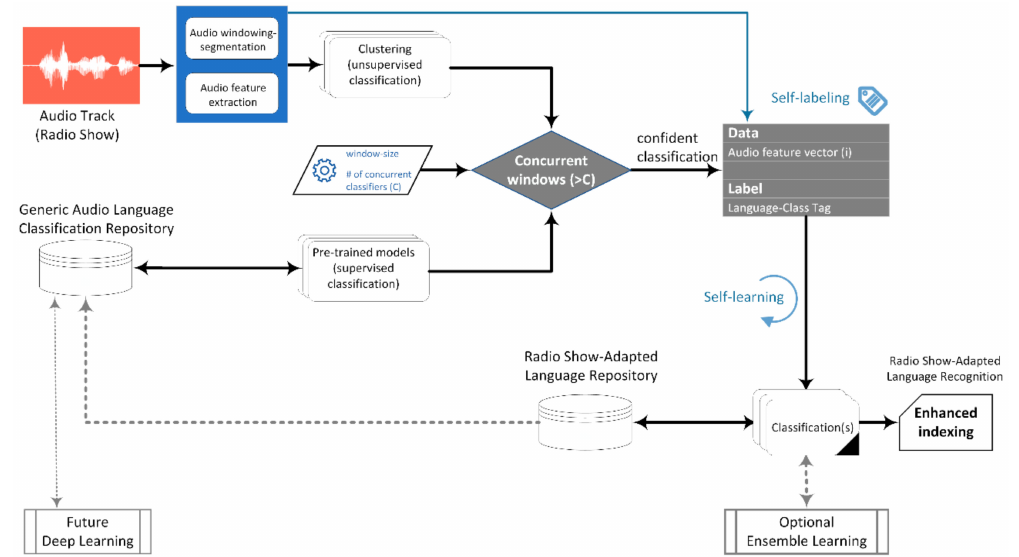
Figure 1. Block diagram of the proposed